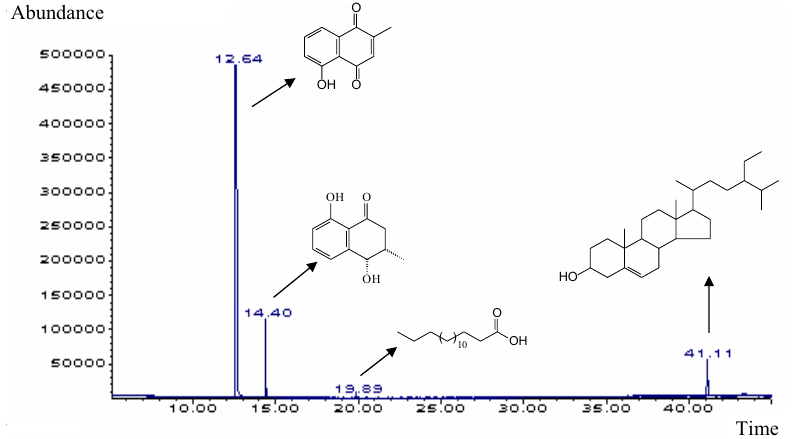
Fig. 4 – Chromatogram of the crude chloroform extract from roots of Plumbago scandens obtained by dynamic maceration.